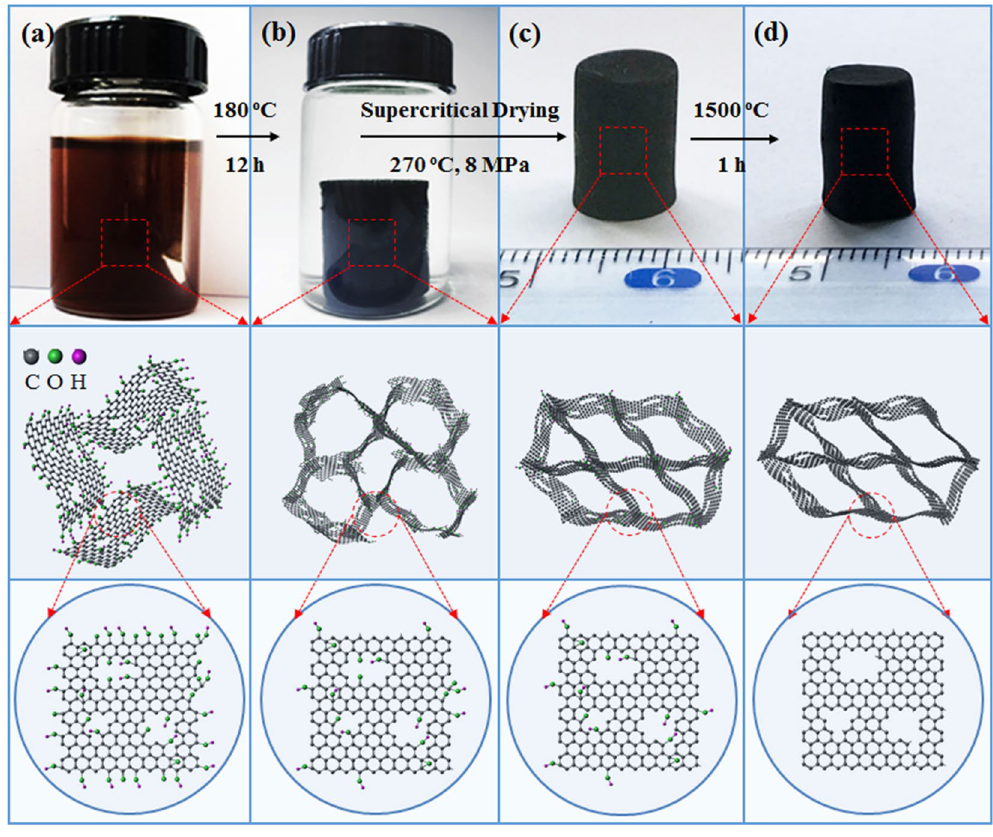
Figure 1. Synthesis of graphene aerogels. ( a ) GO aqueous dispersion, ( b ) graphene hydrogel, ( c ) dried graphene aerogels and ( d ) annealed graphene